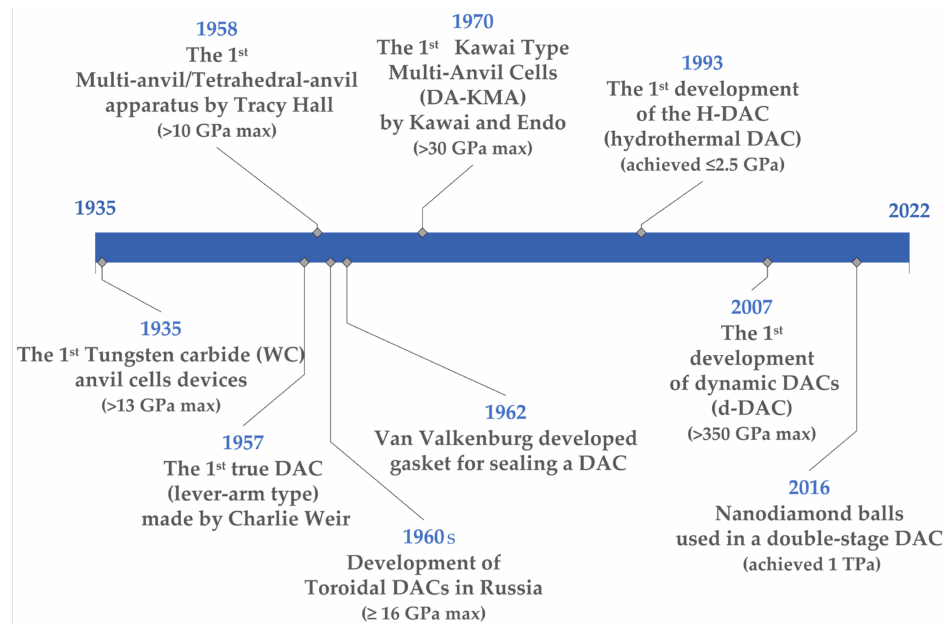
Figure 6. Chronology of Key Basic Diamond Anvil Cell (DAC)